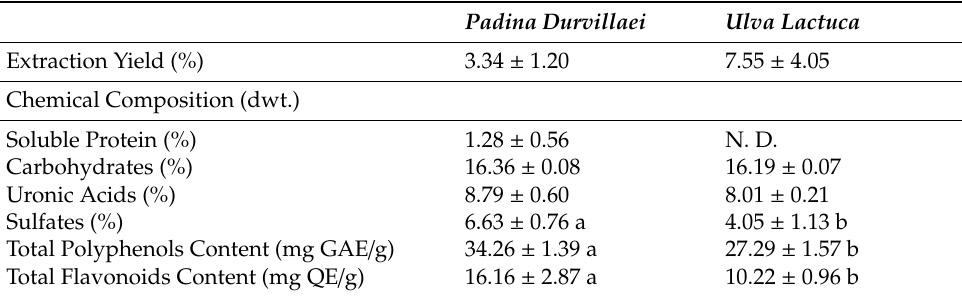
Table 1. Chemical composition of seaweed